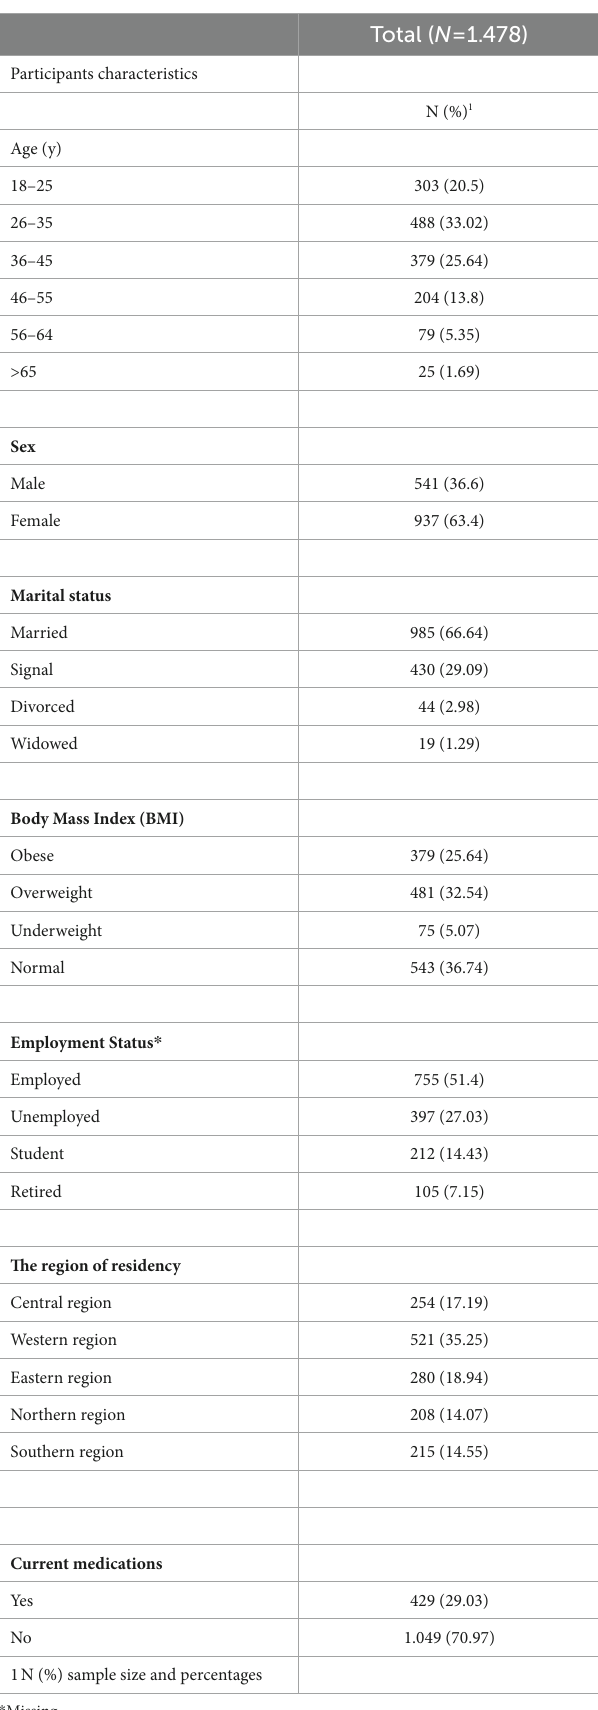
TABLE 1 Demographic characteristics of the participants.